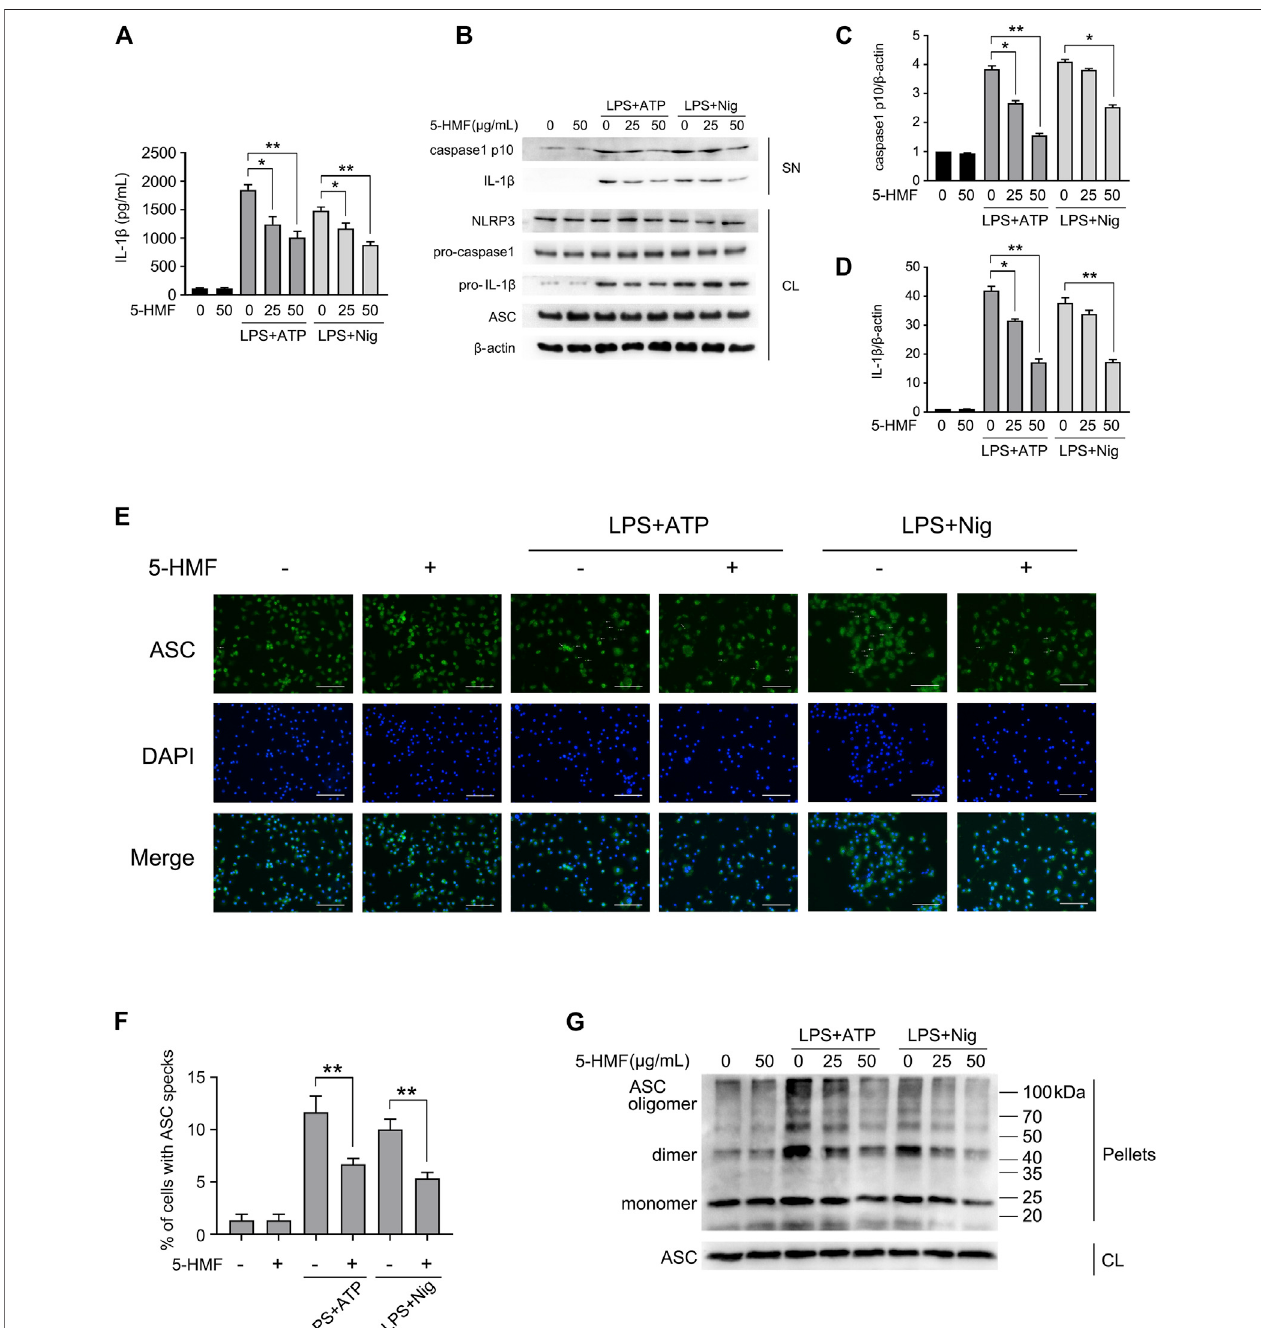
FIGURE 4 | 5-HMF suppresses NLRP3 in fl ammasome activation. BMDMs were pretreated with different concentrations of 5-HMF for 30 min as indicated, followed by LPS (500 ng/ml) for 6 h and ATP (5 mM) or nigericin (10 μ M) for 1 h (A) IL-1 β levels in the culture supernatants. (B) Immunoblot showing levels of indicated proteins in the culture supernatants (SN) and cell lysates (CL). (C,D) The relative band densities of IL-1 β (C) , caspase-1 p10 (D) in the supernatant. (E) Representative immuno fl uorescence images showing ASC speck formation ( × 400), Scale bar, 500 μ m. (F) The percentage of cells containing ASC-specks as in (E) . (G) Immunoblot showing ASC oligomerization in pellets cross-linked by DSS.